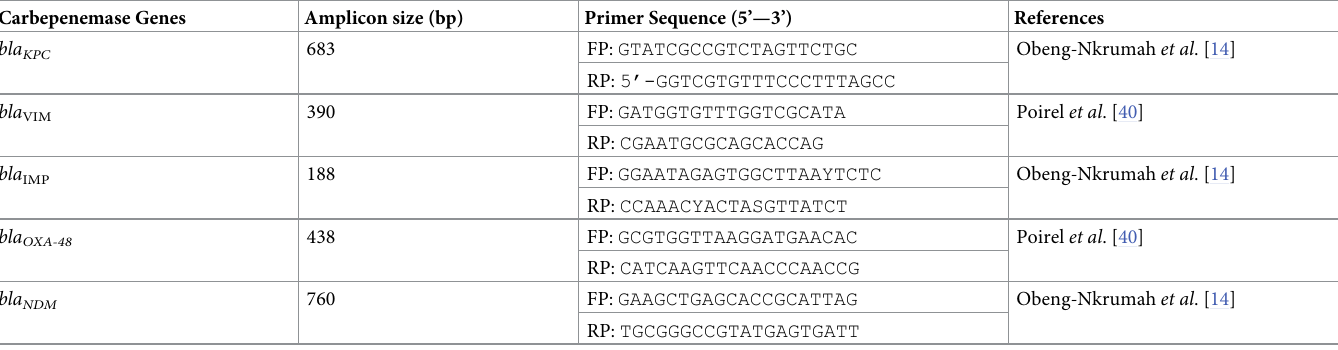
Table 1. Primer sequences used in the detection of the carbapenemase-producing isolates. Carbepenemase